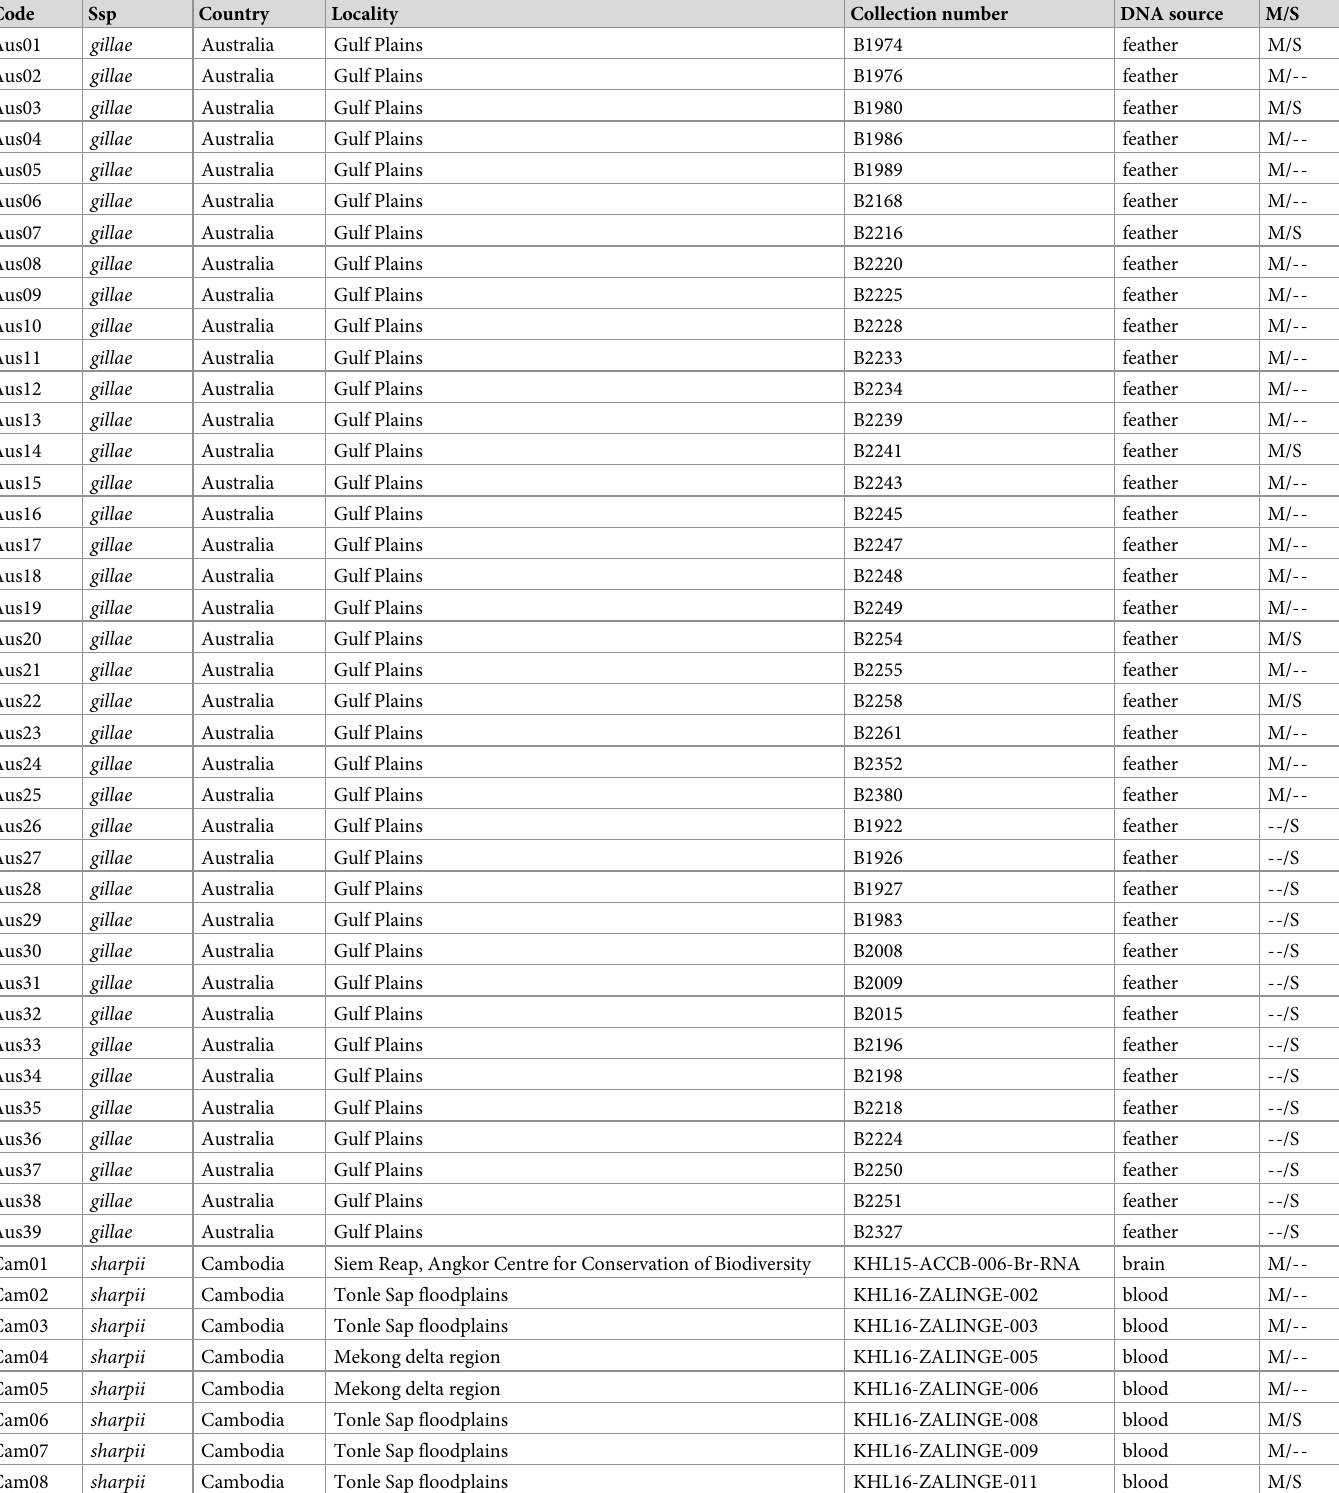
Table 2. Details of sample collections for Sarus Crane (Ssp: subspecies; M: microsatellites; S: sequences). Code